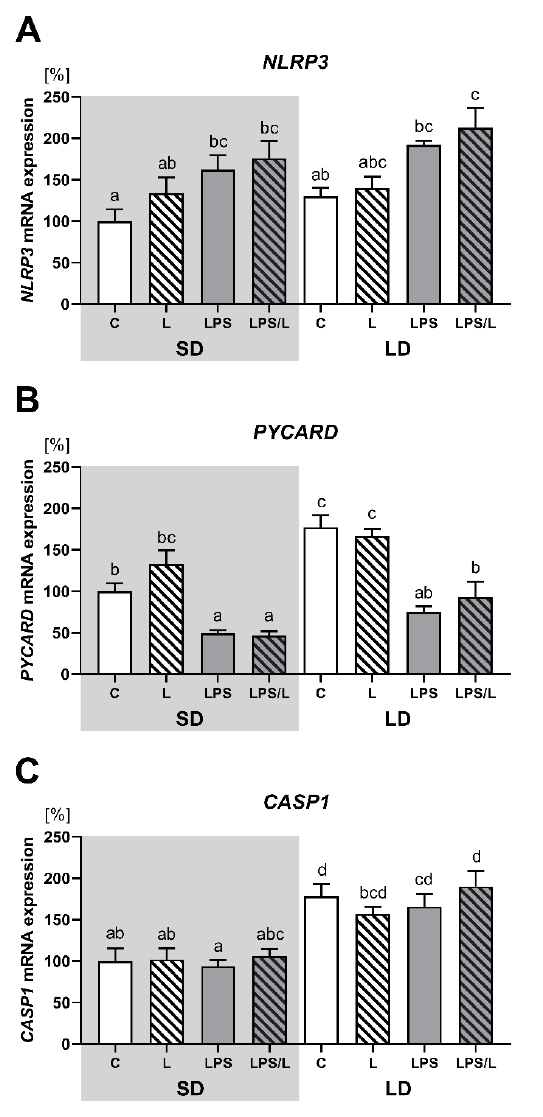
Figure 4. Mean ( ± SEM) relative PYCARD ( A ), NLRP3 ( B ) and CASP1 ( C ) mRNA expression in the ovine choroid plexus of saline (C, control—white bars), saline–leptin (L, white hatched bars), LPS (grey bars) and LPS–leptin (LPS / L, grey hatched bars) treated ewes, during the short-day (SD, dark background) and the long-day (LD, light background) photoperiod. Di ff erent lowercase letters indicate significant di ff erences between all groups at p < 0.05 (two-way ANOVA—Tukey’s post hoc test). The results are presented as percentage values (%), where the SD C group is considered as 100%.